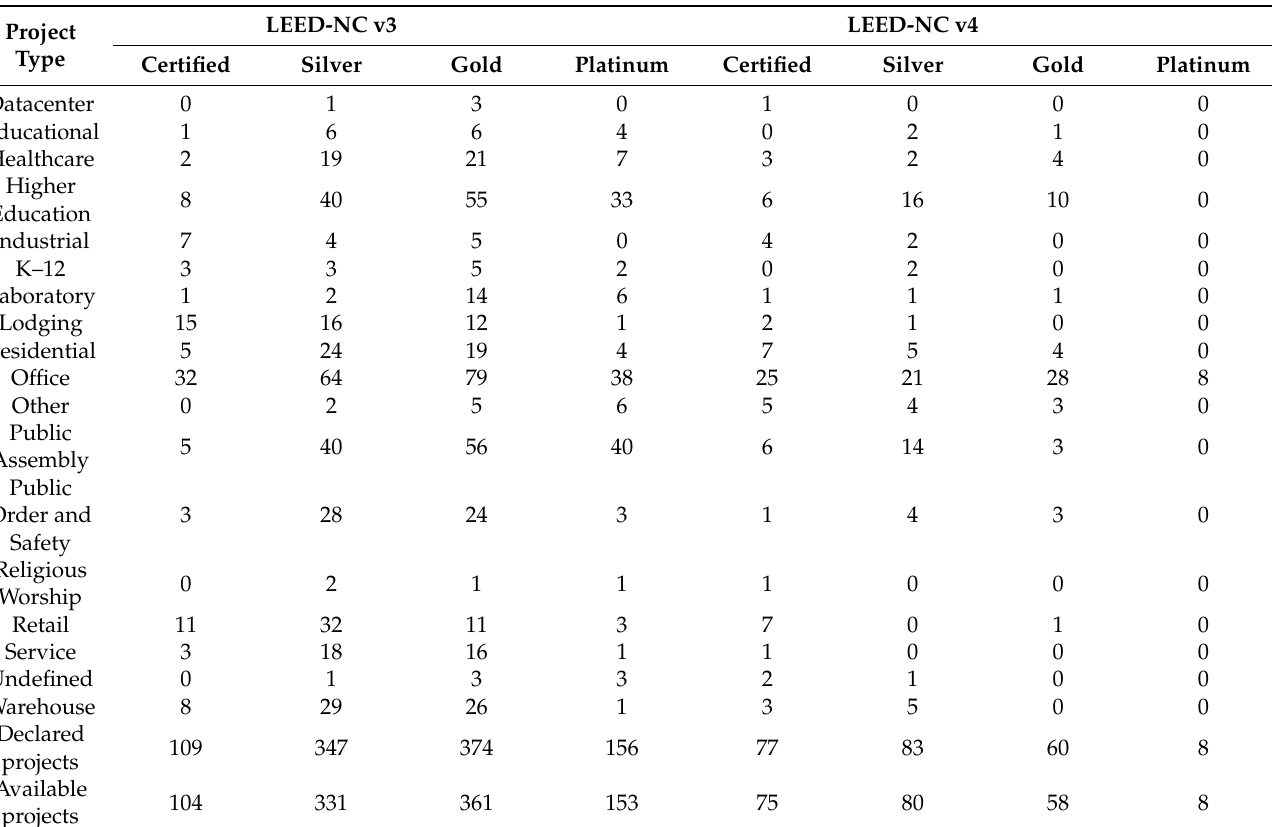
Table 2. The LEED-NC v3/v4 project distribution among space-types (accessed on 25 February